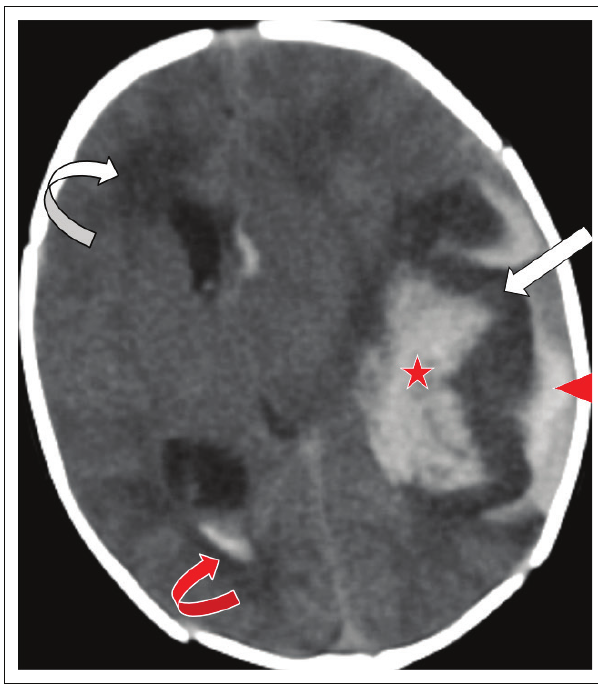
FIGURE 1: Axial CT brain. Localised extra-axial hyperdensity in the left temporal region (red arrowhead) and left temporal lobe parenchymal hyperdensity (red star) representing subpial haemorrhage with intraparenchymal extension. The cortical hypodensity (white arrow) represents ischaemia. Blood products also identified in the ventricular system (red curved arrow) with hydrocephalus and transependymal oedema (white curved